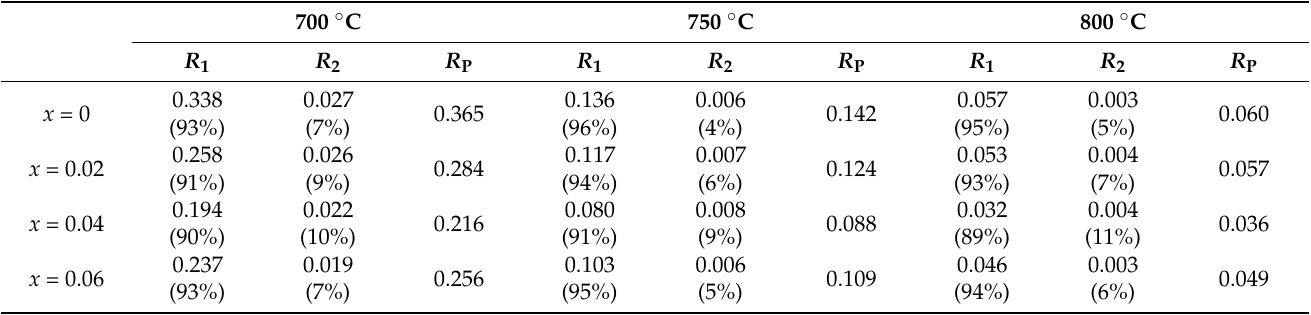
Table 3. R 1 , R 2, and R P values of LBCM x (Units: Ω cm 2 ). 700 ◦ C